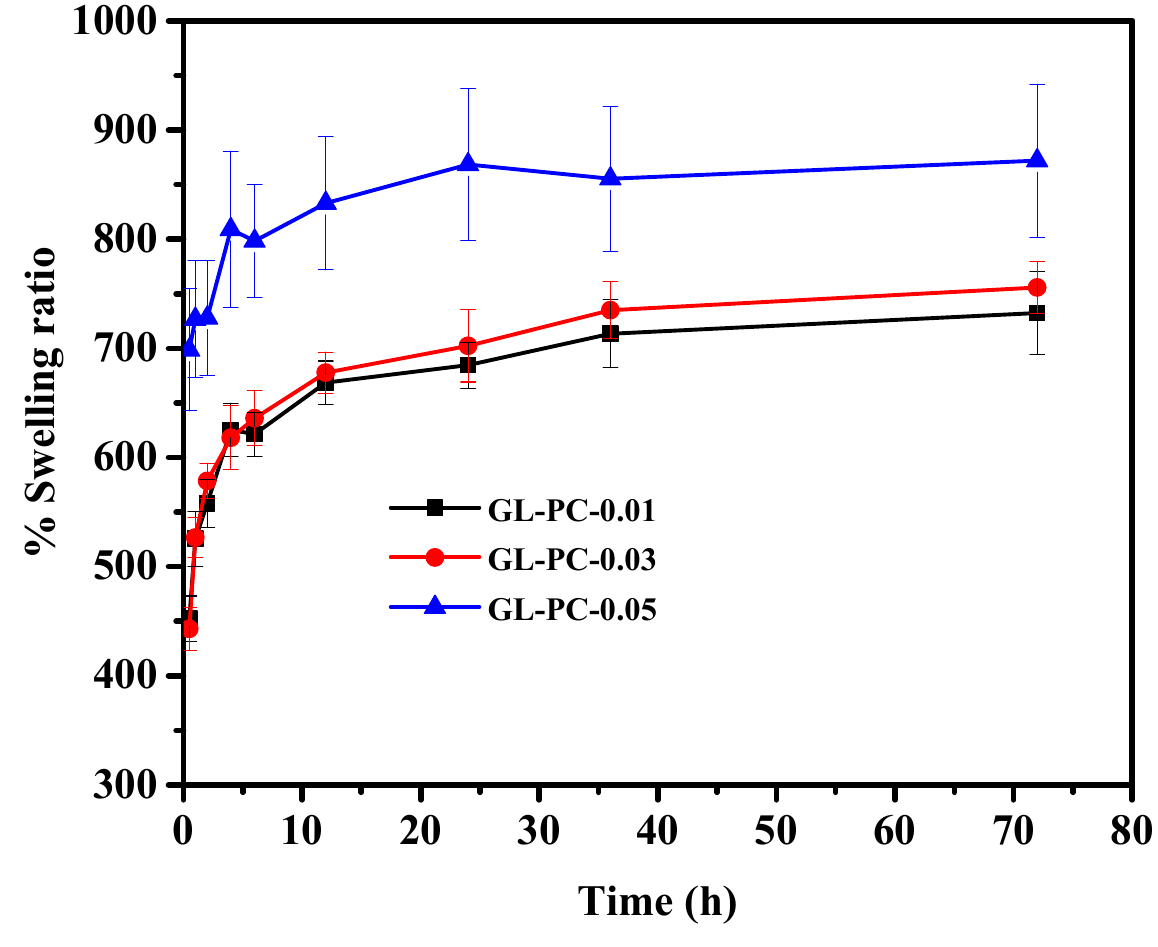
Figure 5. Swelling study of GL-PC hydrogels in PBS at 37 °C .